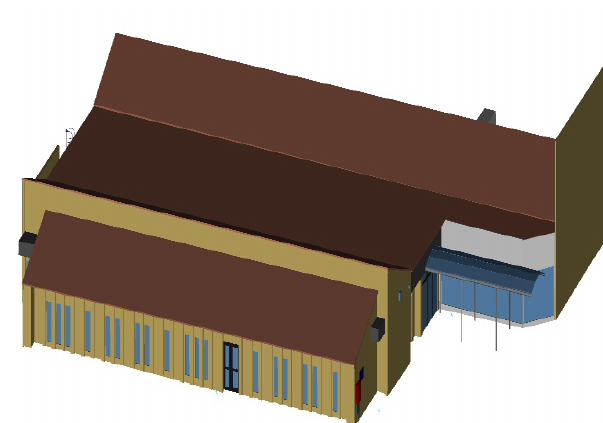
Figure 9: Expected reconstructed building model from segment- ed data. Different terminal elements are shown in differen- t colours. Window elements are in blue, wall elements are in gold and the roof is in